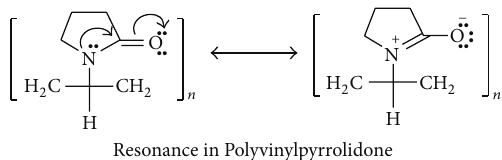
Scheme 1: Schematic presentation of resonating structure of poly-